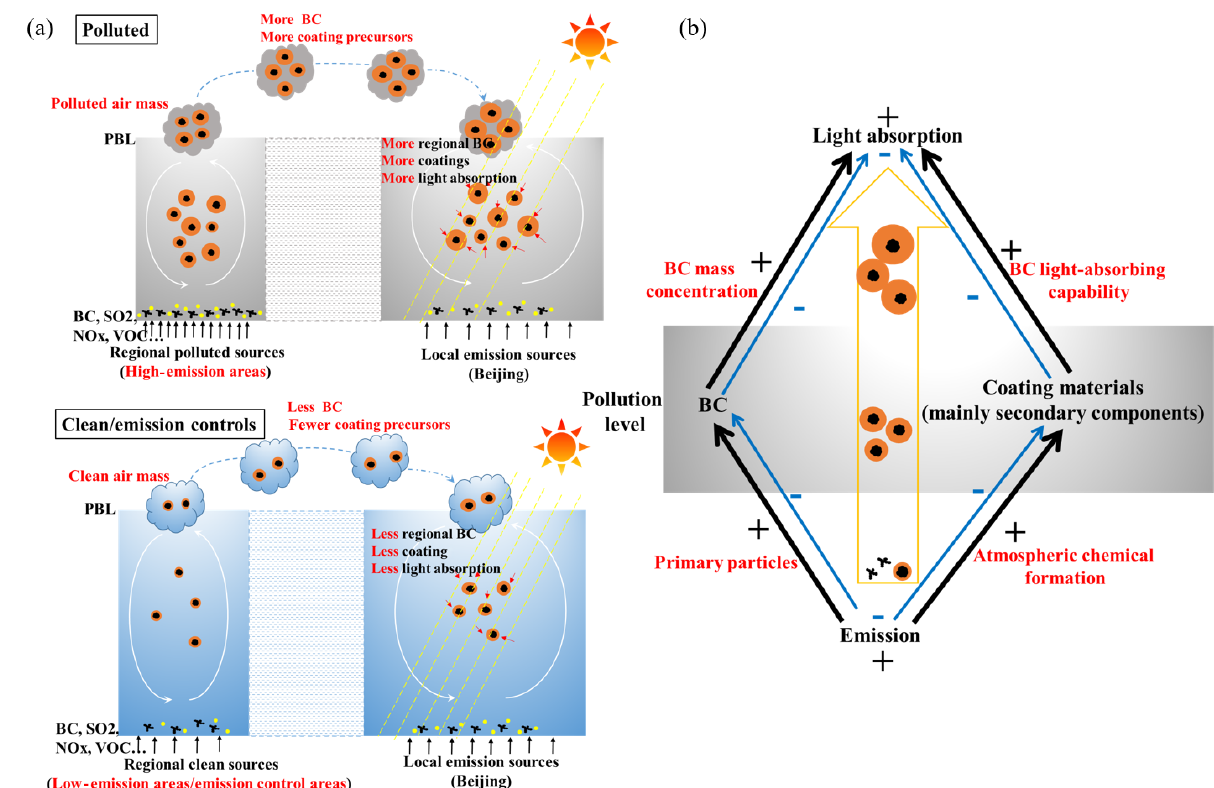
Figure 8. Conceptual scheme of the amplification effect on BC light absorption associated with air